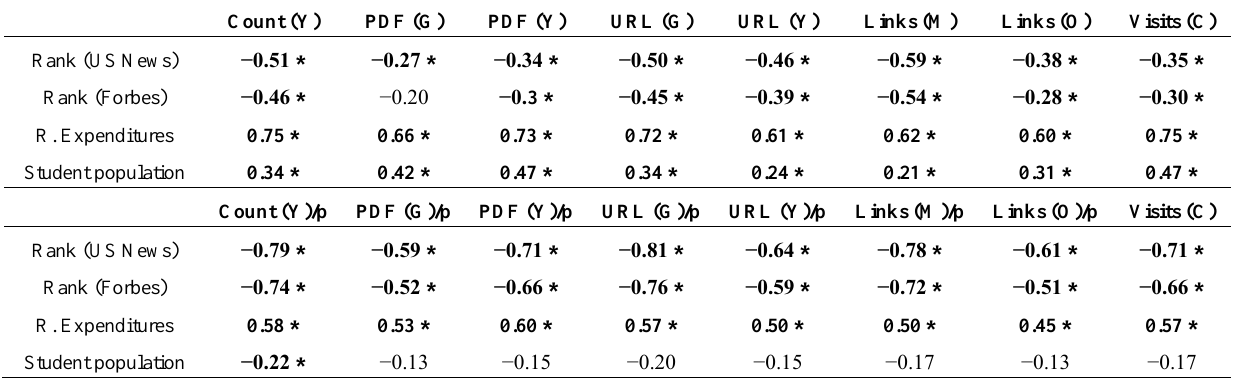
Table 4. Correlation among institutional and web data (university